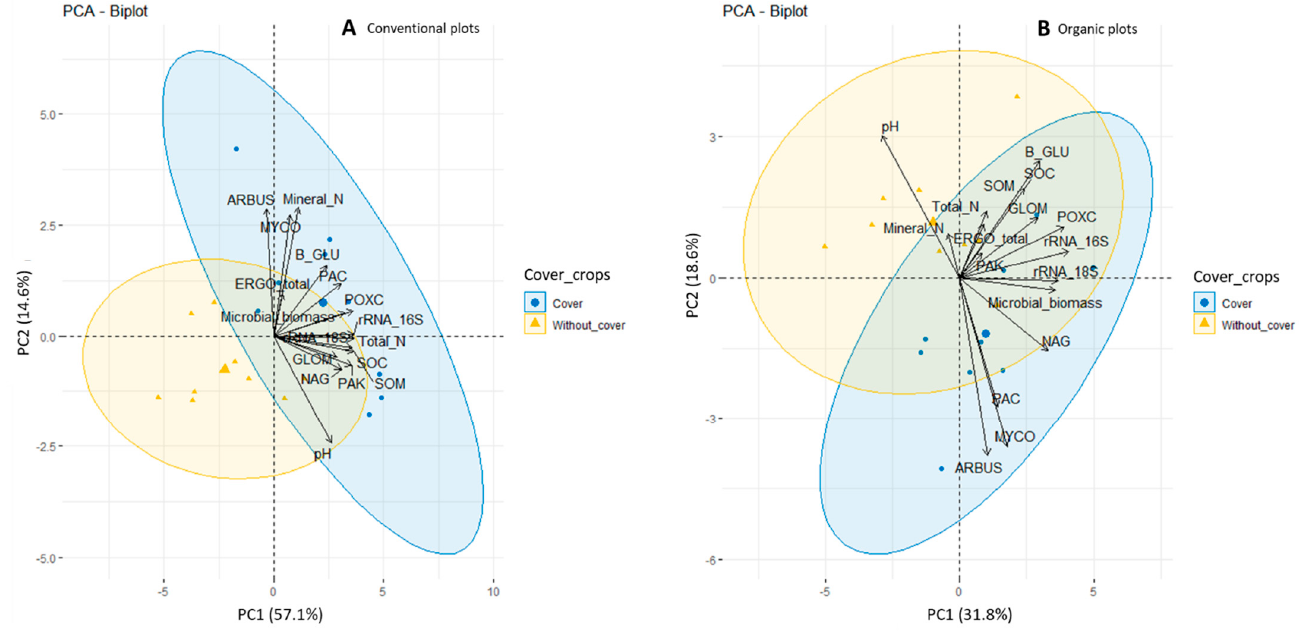
Figure 5. PCA biplot of biological and physicochemical data from conventional ( A ) and organic ( B ) plots with or without cover. Only the first two axis are shown on the biplot. MYCO—Mycorrhizal intensity; ARBUS—arbuscule abundance; ERGO total—total ergosterol; GLOM—glomalin; rRNA_16S—bacterial abundance; rRNA_18S—fungal abundance; β -GLU— β -glucosidase; NAG— N-acetylglucosaminidase; PAC—acid phosphatase; PAK—alkaline phosphatase; POXC—perman-